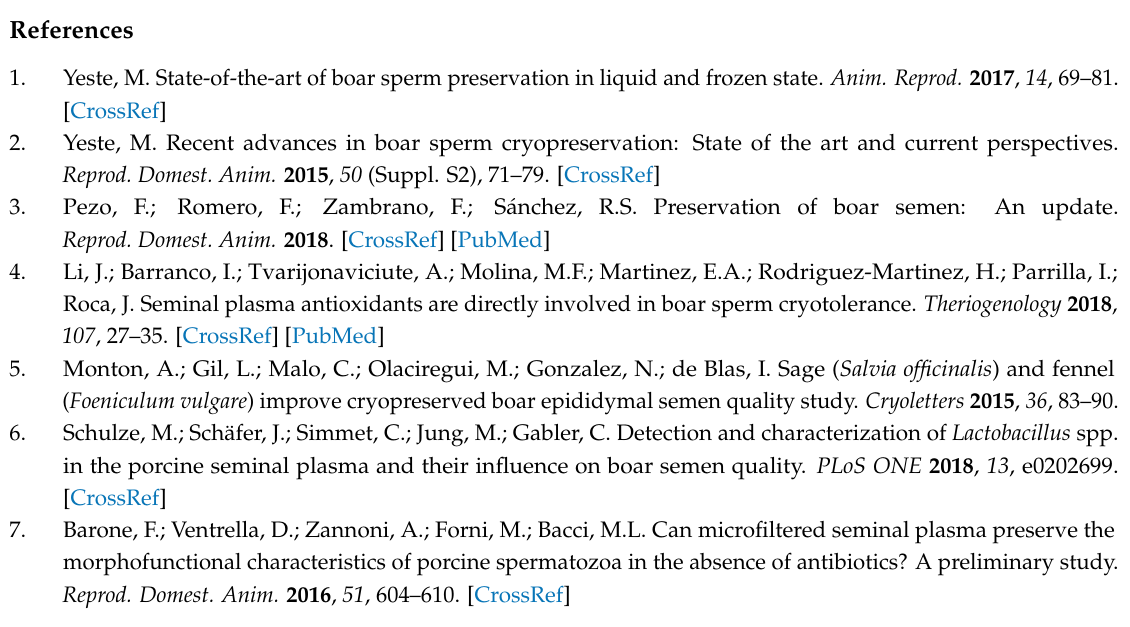
Supplementary Materials: The Supplementary Materials are available online. Table S1: descriptive statistics of the effects of tea tree oil on semen morpho-functional parameters, Table S2: descriptive statistics of the effects of terpinen-4-ol on semen morpho-functional